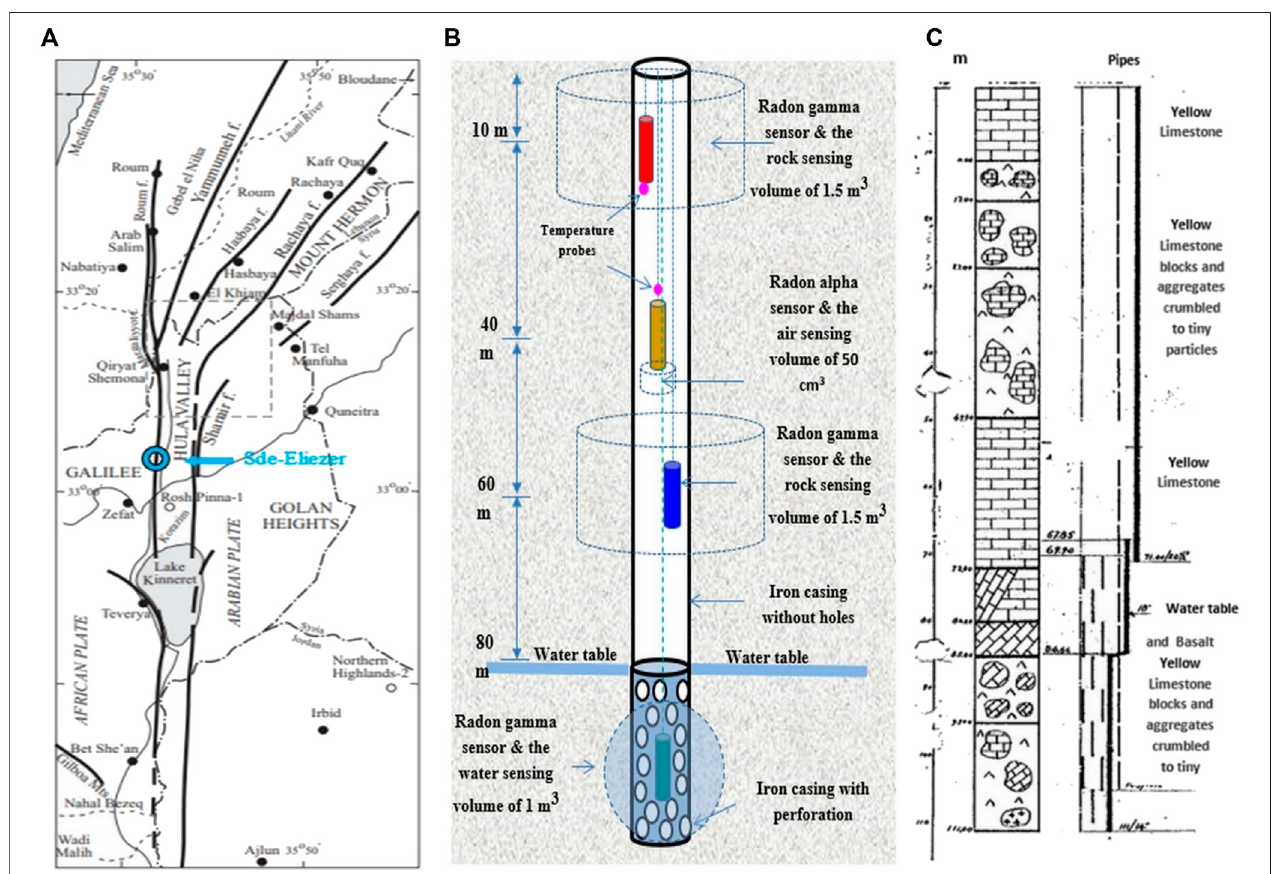
FIGURE8|(A) SdeEliezer siteintheHulabasinwesternborder fault — HWBF,andmapofthemainsegmentsoftheDeadSeaFaultZone(DSFZ)innorthernIsrael (Weinberger et al., 2009). (B) The radon monitoring setup. (C) The geological column section.